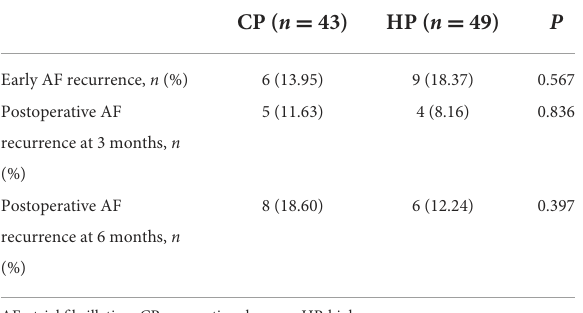
TABLE 4 AF recurrence analysis.